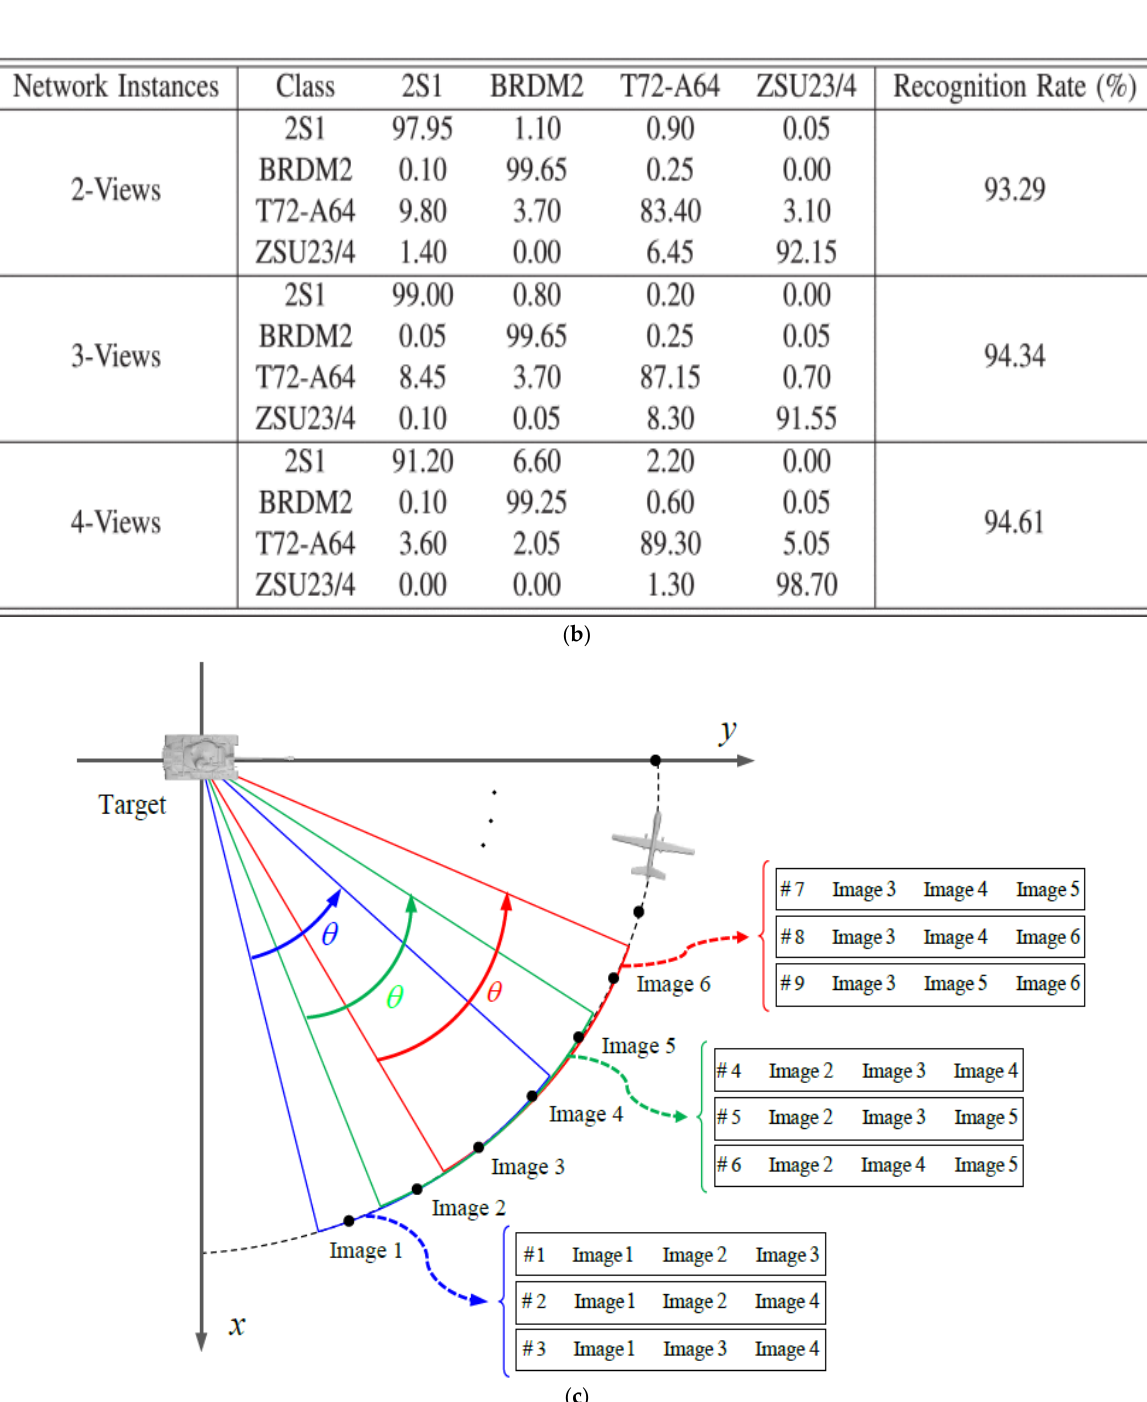
Figure 7. Illustrations of Multiview SAR (Synthetic Aperture Radar) ATR (Automatic Target Recognition) and Multiview SAR image combinations’ generation for training. ( a ) Geometric model of Multiview SAR ATR for a ground target, ( b ) confusion matrix under extended operating condition with recognition rate for each Multiview, and ( c ) example of nine three-view SAR image combinations’ generation from only six raw SAR image [109].